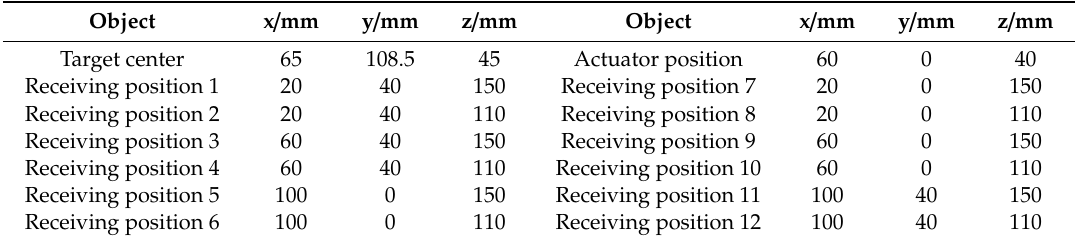
Table 1. The coordinates of the actuator, the 12 receiving positions, and the target.